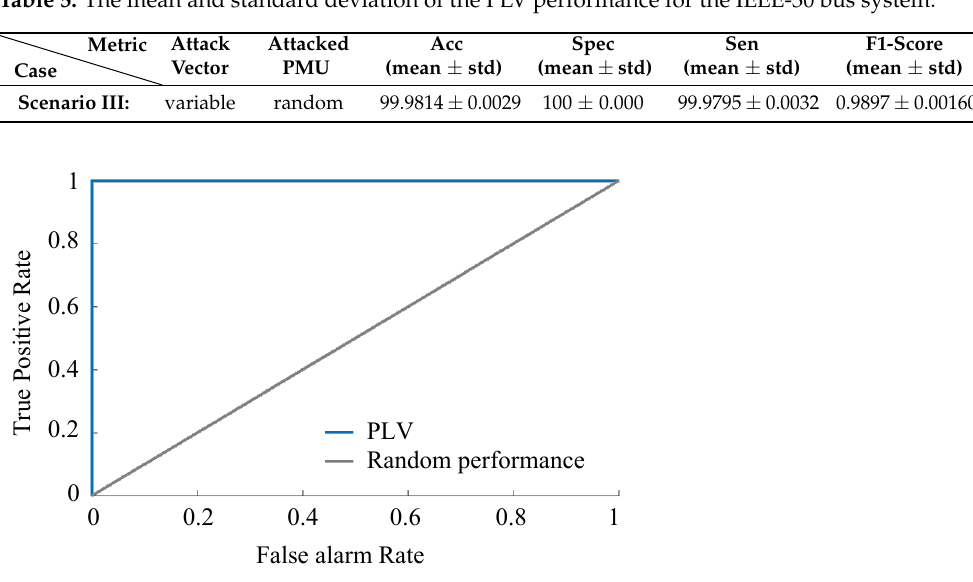
Figure 8. Performance for IEEE-14 system, Scenario III and case number 19 (randomly chosen): ROC curve of the proposed method along with reference ROC curve representing 50% sensitivity and 50%